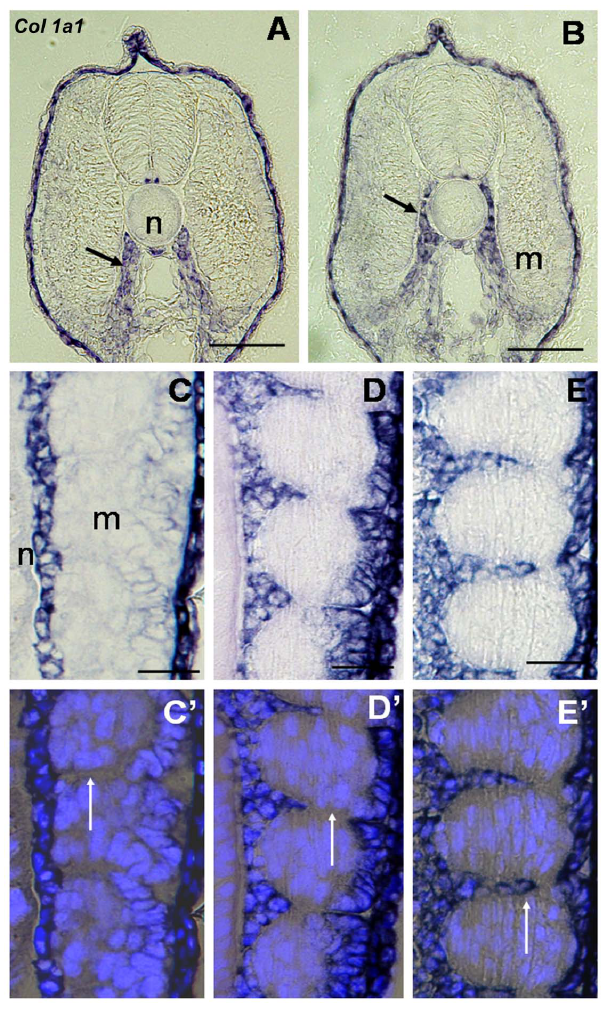
Figure 4. Apparent movement of col1a1 expressing cells suggests a sclerotomal origin of myoseptal cells. ( A ) Transverse section of a 13 dpf embryo. Col1a1 staining is present in the ventrally located sclerotome cells (arrow). ( B ) Transverse section of a 14 dpf embryon. Labelled cells have migrated dorsally to surround the notochord (arrow). ( C – E ) Frontal section of trout embryo at the level of the notochord. ( C ) 14 dpf embryo. Labelled cells surround the notochord. ( D ) 15 dpf embryo. Some labelled cells occupy the medial aspect of the intermyotomal space. ( E ) 16 dpf embryo. The medial- lateral extent of the intermyotomal space contains labeled cells. ( C 9 – E 9 ) Merged images showing col1a1 labelling and Hoechst nuclear staining, white arrows indicate the intermyotomal space. n: notochord; m: myotome. Scale bars in A and B, 50 m m; C, C 9 , D, D 9 , E and E 9 , 30 m m.